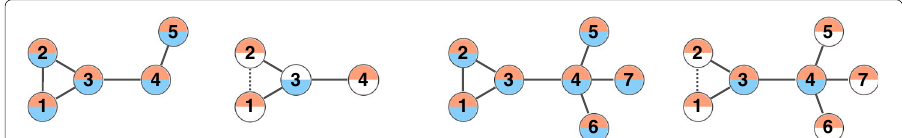
Fig. 3 The 3-StS cores of the two graphs from Example 3. On the left, the first graph followed by its 3-StS core subgraph whose edges (in plain lines) relate stars (in blue) to satellites (in red). On the right, the second graph followed by its 3-StS core